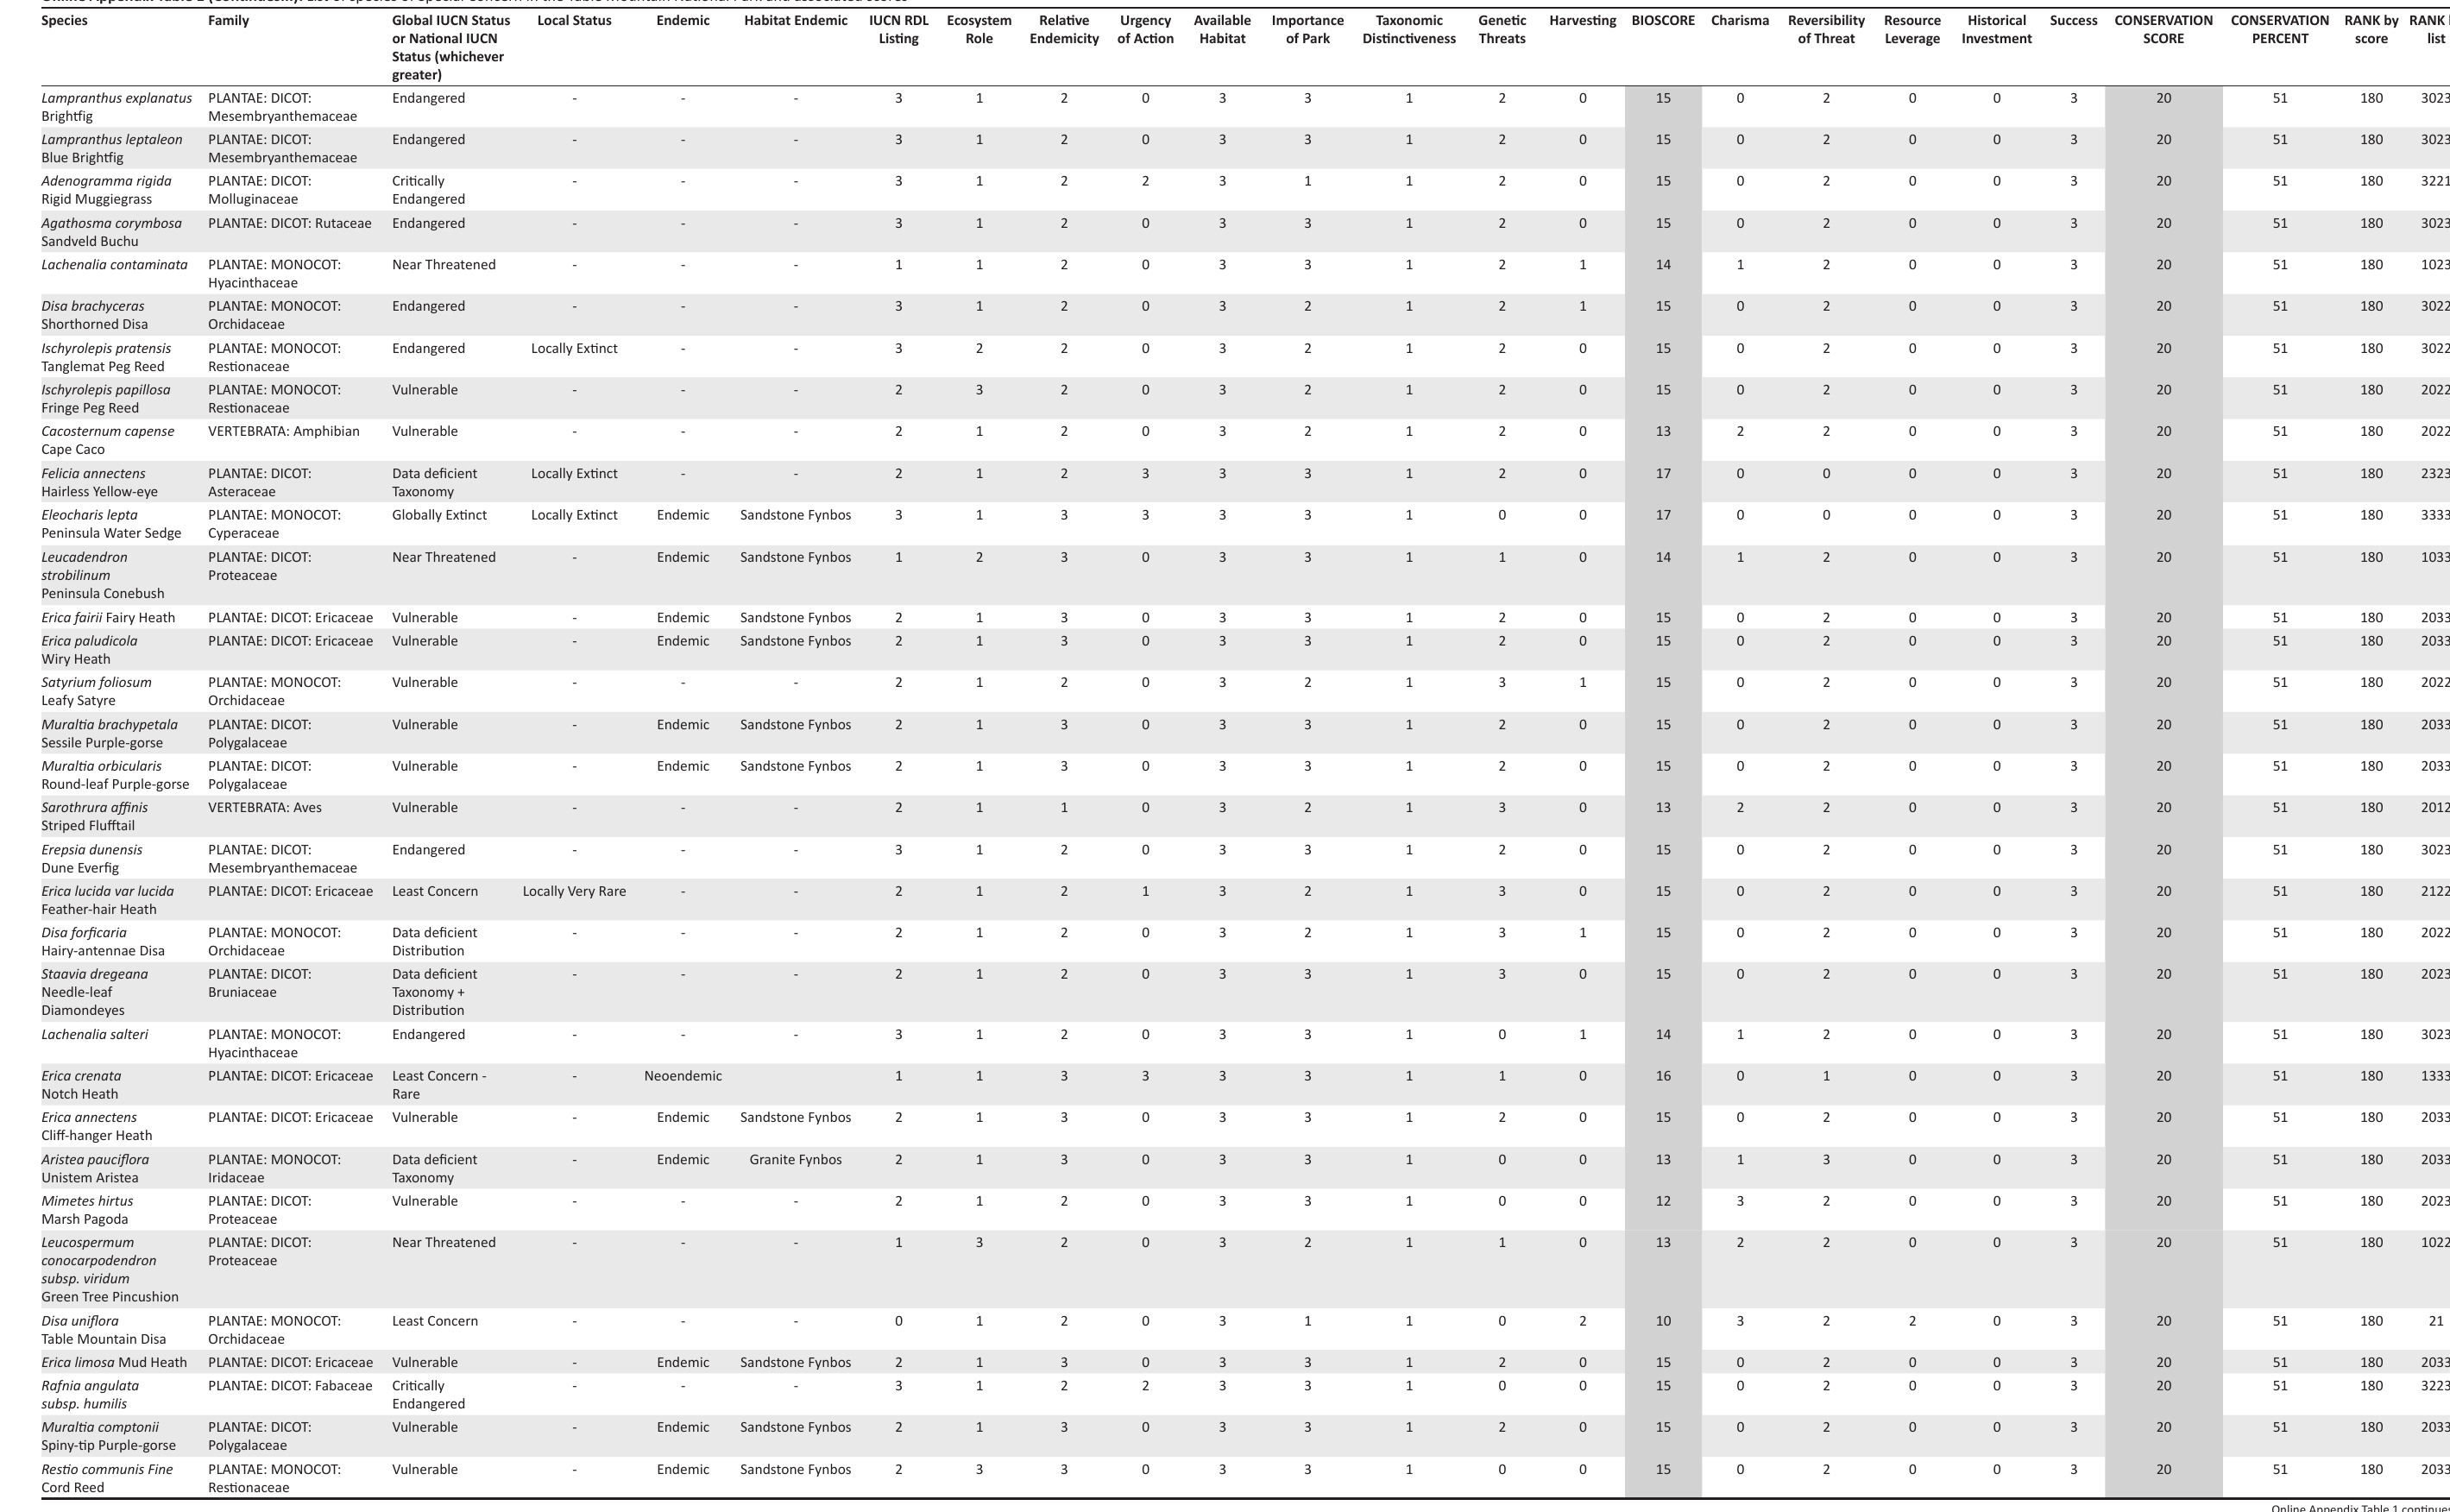
Online Appendix Table 1 (Continues...): List of species of Special Concern in the Table Mountain National Park and associated